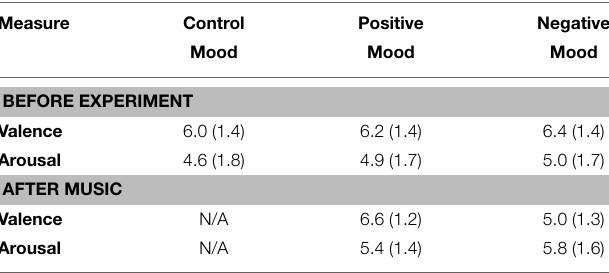
TABLE 3 | Means (with SDs) of valence and arousal ratings across mood groups during the experiment.